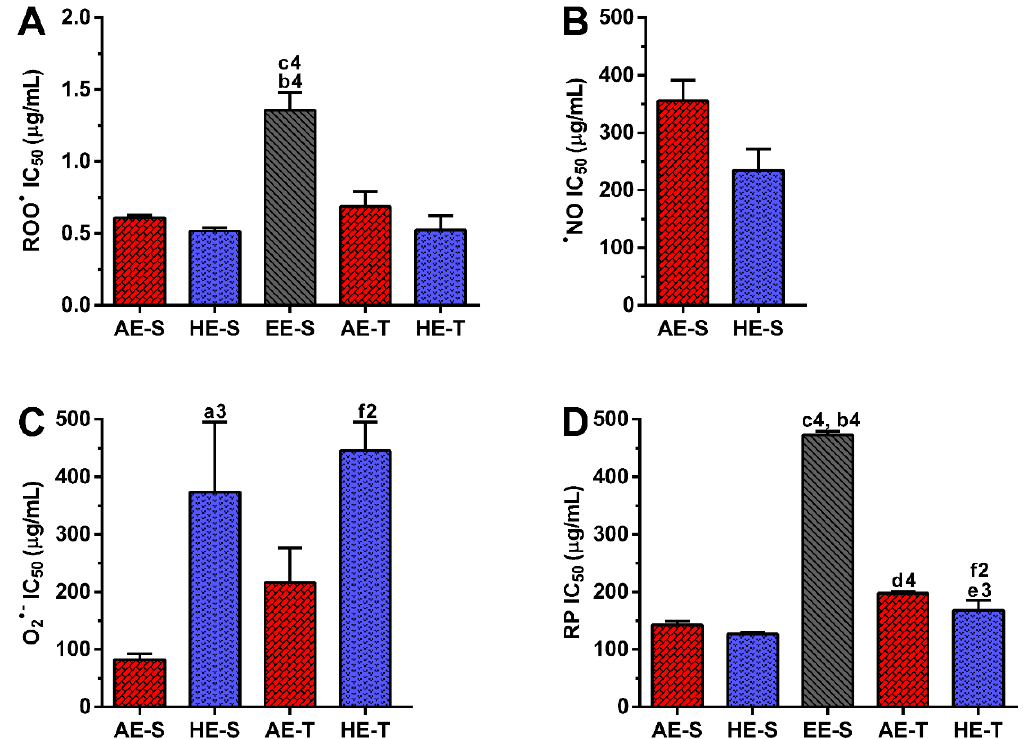
Figure 4. Half-maximal inhibitory concentration (IC 50 , µg/mL) of the different Salvia officinalis extracts against ROO • ( A ), • NO ( B ), and O 2 •− ( C ), as well as their reducing power (RP) ( D ). Statistically significant differences are 1 ( p < 0.0105), 2 ( p < 0.0032), 3 ( p < 0.0002), 4 ( p < 0.0001) in comparison with a (AE-S vs. HE-S), b (AE-S vs. EE-S), c (HE-S vs. EE-S), d (AE-S vs. AE-T), e (HE-S vs. HE-T), and f (AE-T vs. HE-T). AE: aqueous extracts; HE: hydroethanolic extracts; EE: ethanolic extracts; S: soxhlet extraction; T: traditional extraction.